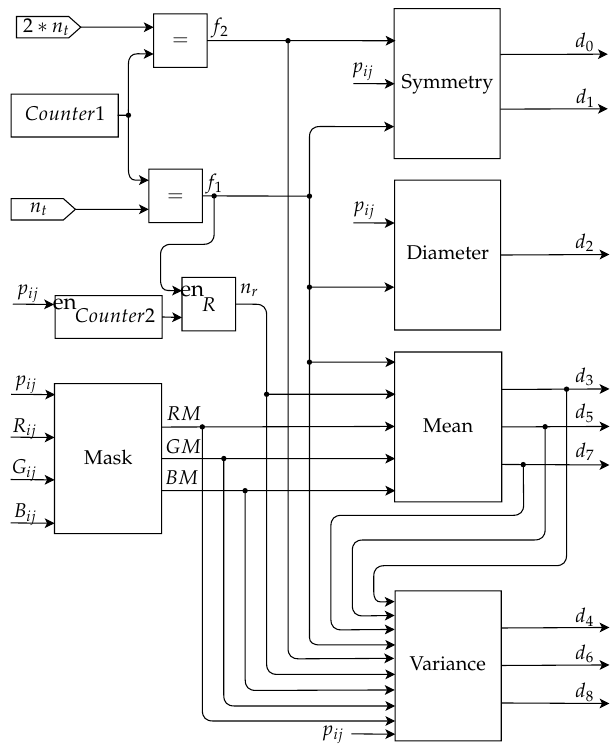
Figure 9. Digital image processing module